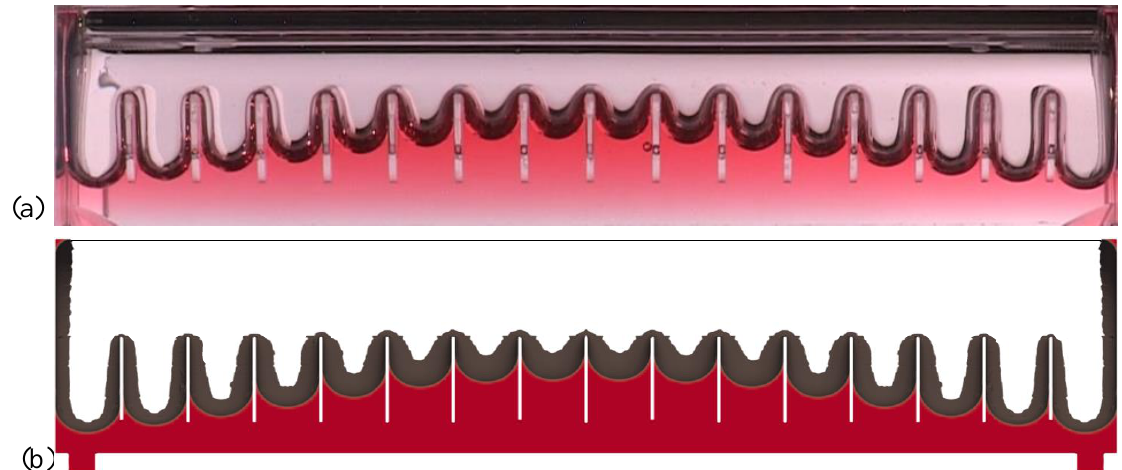
Figure 12. 3D side perspective of the ICF-8 Tapered Section filled with liquid (red) at t = 25 s ( a ) during experiment and ( b ) simulation, where gray implies interfacial volume fraction α = 0.5.